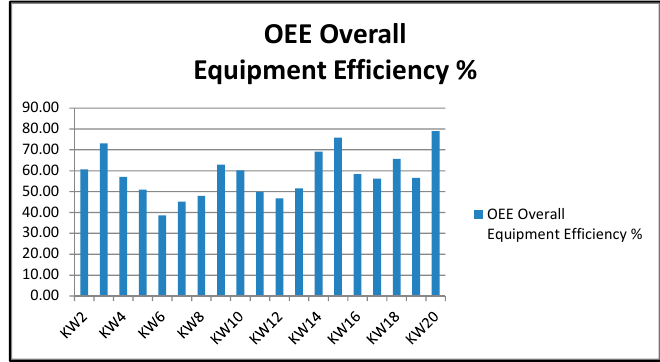
Figure 1. Evolution of the overall equipment efficiency (OEE) in the first months of 2016.